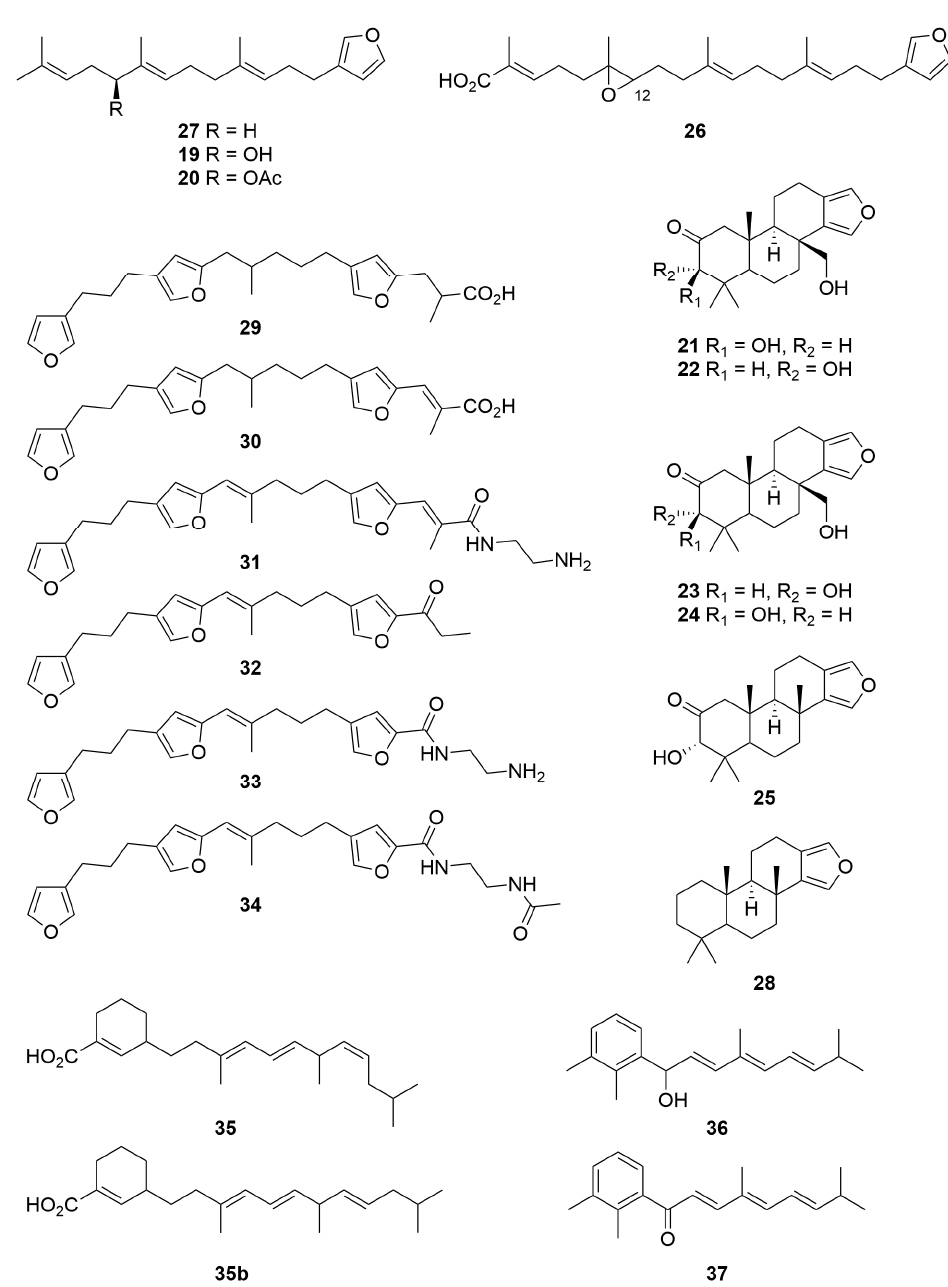
Figure 2. Compounds 19 to 37 .